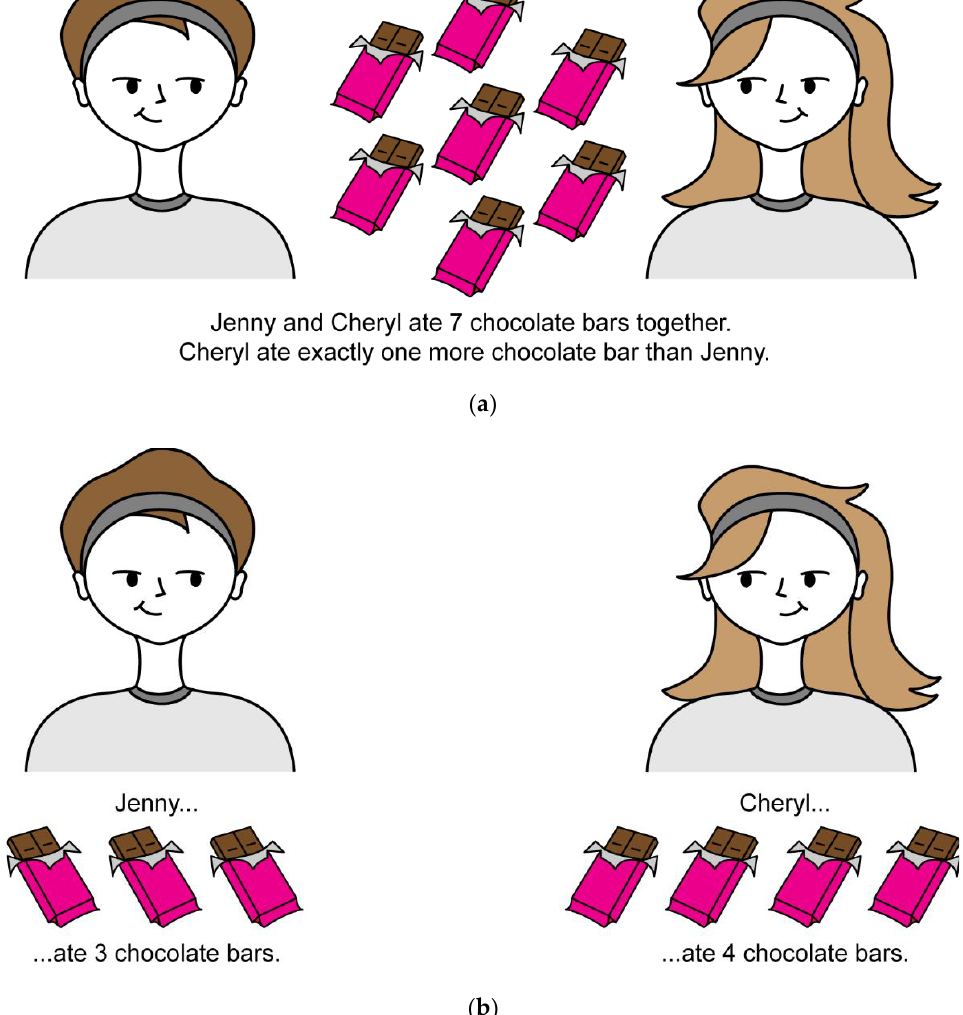
Figure 2. ( a ) Indirect statements are given about the relationship between Jenny, Cheryl, and the 120 number of chocolate bars eaten by each. Logical inference is required to deduce what the infor- 121 mation is, that Cheryl ate four chocolate bars, while Jenny ate three. Accurate representation of the